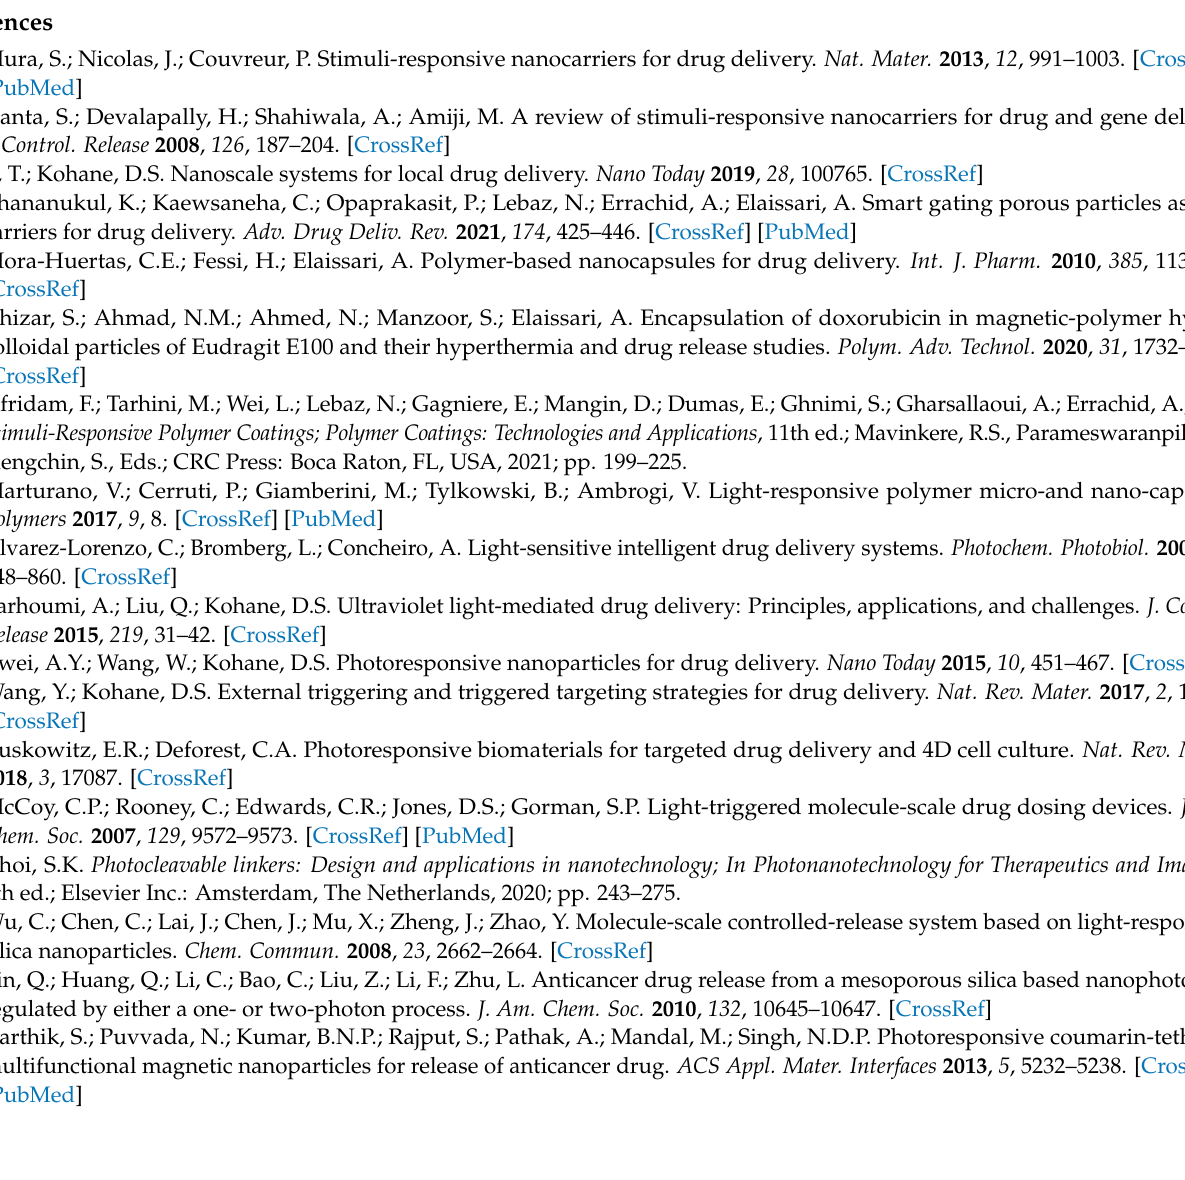
Figure S6: MS spectrum of o -nitrobenzyl bis-trimethoxysilylpropyl carbamate, Figure S7: The calcu- lated chemical structures of o –NB monomer ( a ) and photolysis by-product o -nitrosobenzaldehyde ( b ), Figure S8: DOX release profiles of DOX@BPS from 0 to 16 h at different laser intensities (0, 60,160, and 200 mW/cm 2 ) in PBS buffer solution (pH 7.4) at 37 ◦